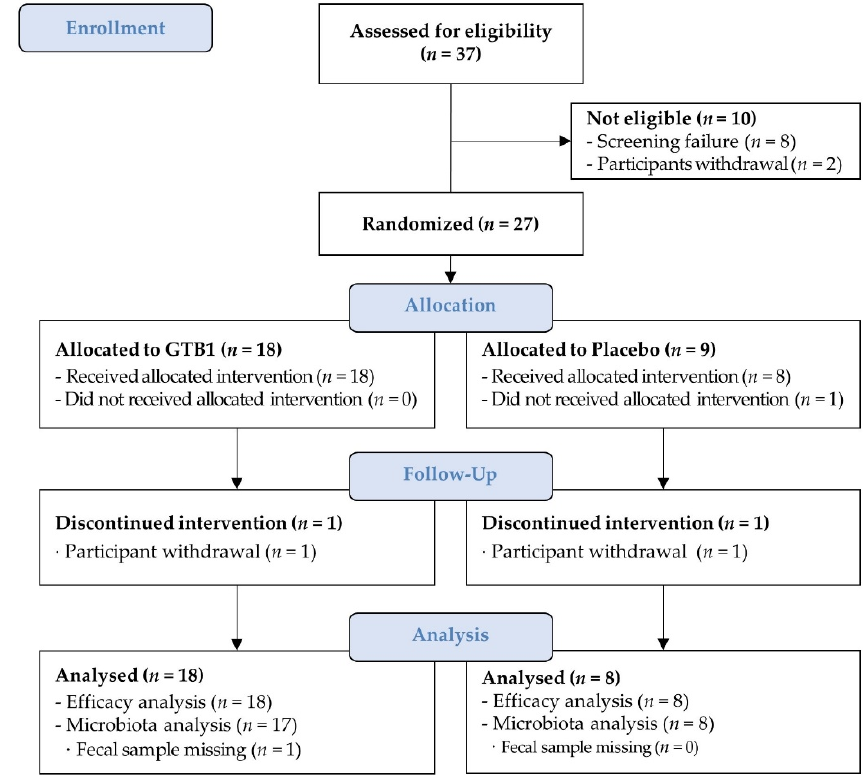
Figure 1. Participant flow chart.